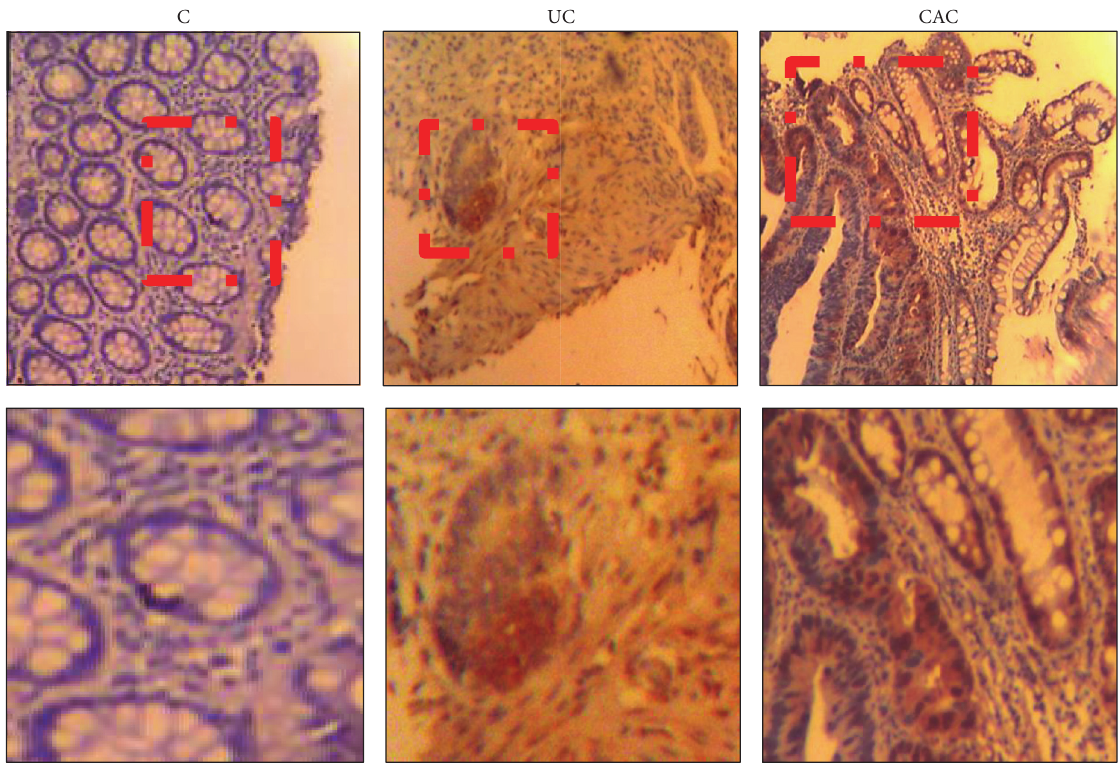
Figure 8: Immunohistochemical expression of TLR4. Control colonic mucosa shows a low expression of TLR4 (score 0). This expression was profoundly increased in colonic mucosa of patients UC (score 3) and CAC (score 3) (UC: ulcerative colitis, 𝑛 = 6 ; CAC: colitis associated cancer, 𝑛 = 4 ; C: control, normal mucosa, 𝑛 = 3